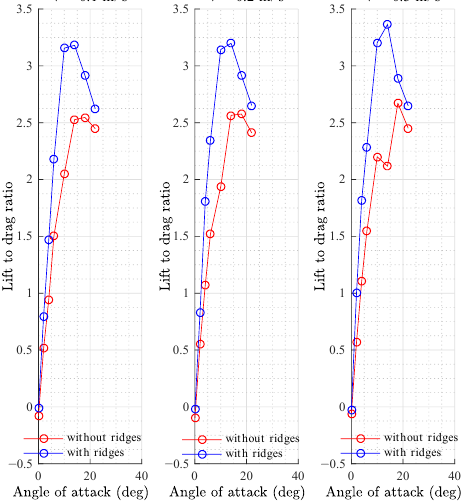
Figure 10. Lift-to-drag ratio at different